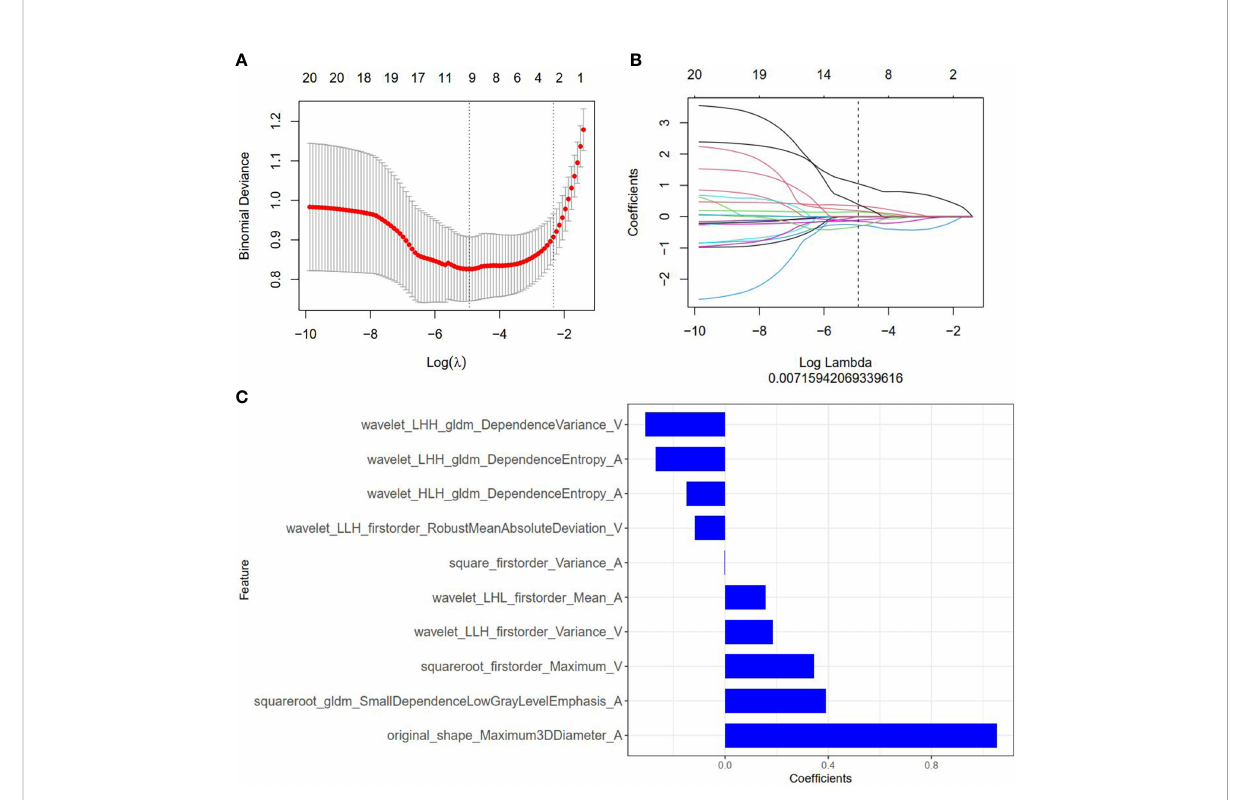
FIGURE 2 Radiomics feature selection by using the least absolute shrinkage and selection operator (LASSO) logistic regression. (A) Selection of the tuning parameter ( l ) in the LASSO model via 10-fold cross-validation based on minimum criteria. Binomial deviances from the LASSO regression cross- validation model are plotted as a function of log( l ). The y-axis shows binomial deviances and the lower x-axis the log( l ). Numbers along the upper x-axis indicate the average number of predictors. Red dots indicate average deviance values for each model with a given l , and vertical bars through the red dots indicate the upper and lower values of the deviances. The vertical black lines de fi ne the optimal values of l , where the model provides its best fi t to the data. An optimal l value of 0.007 with log( l ) =-4.962 was selected. (B) The coef fi cients have been plotted vs. log( l ). (C) The 10 features with nonzero coef fi cients are shown in the